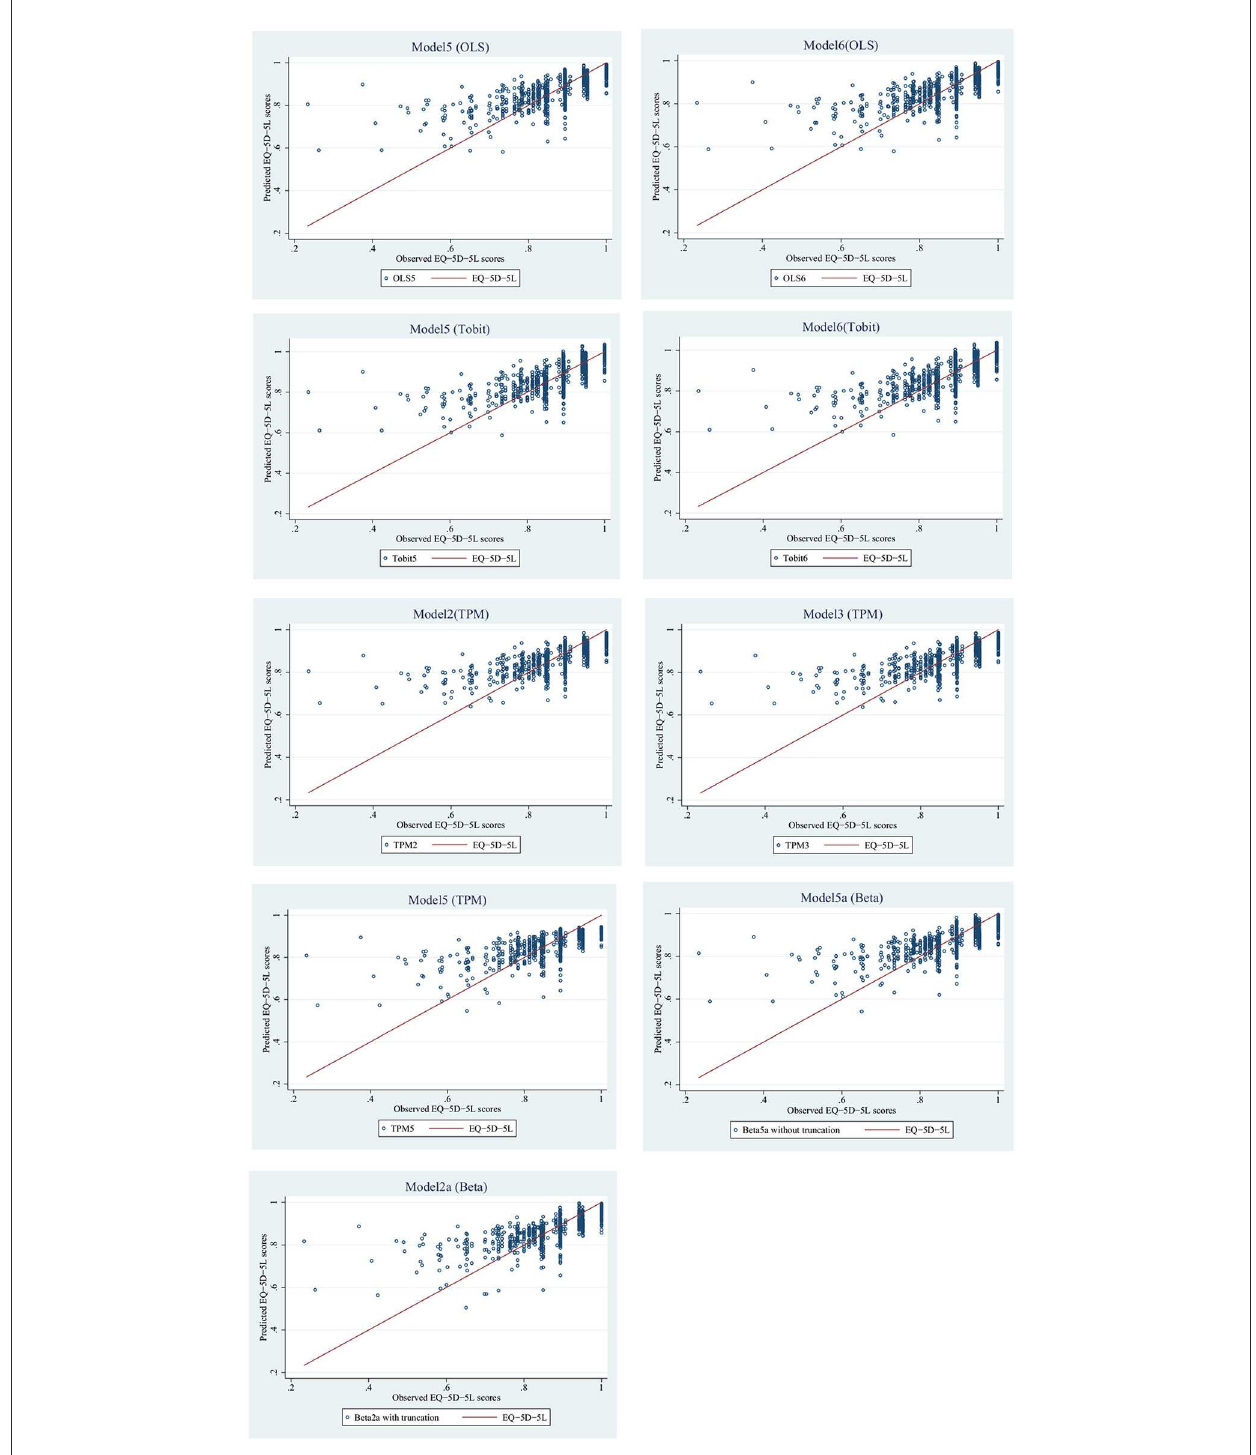
FIGURE2 Correlation between observed and predicted utility values of nine optimal models.